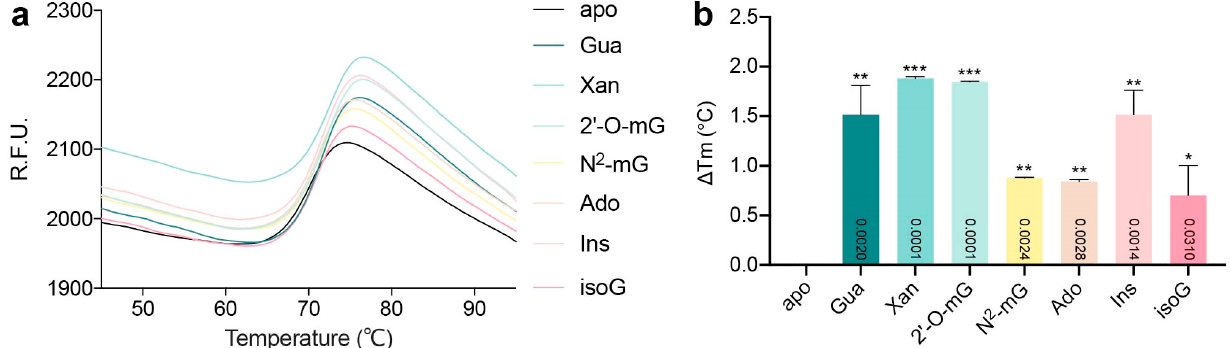
Figure 4. The TSA melting curves of various ligands to AtGSDA. ( a ) The melting curves of the enzyme in complex with various ligands. The horizontal axis indicates temperature while the vertical axis indicates relative fluorescence units (R.F.U.). ( b ) The comparison of the stabilizing effects brought by the ligands. Δ Tm represents the changes in Tm values between the complexes and the apo-enzyme. Error bars are standard deviation (s.d.) ( n = 3 biological replicates). Statistical evaluation with ANOVA is followed by Tukey’s post test. Probability values for pairwise comparisons to apo are shown at the respective bars. *: p < 0.05, **: p < 0.01, ***: p < 0.001.